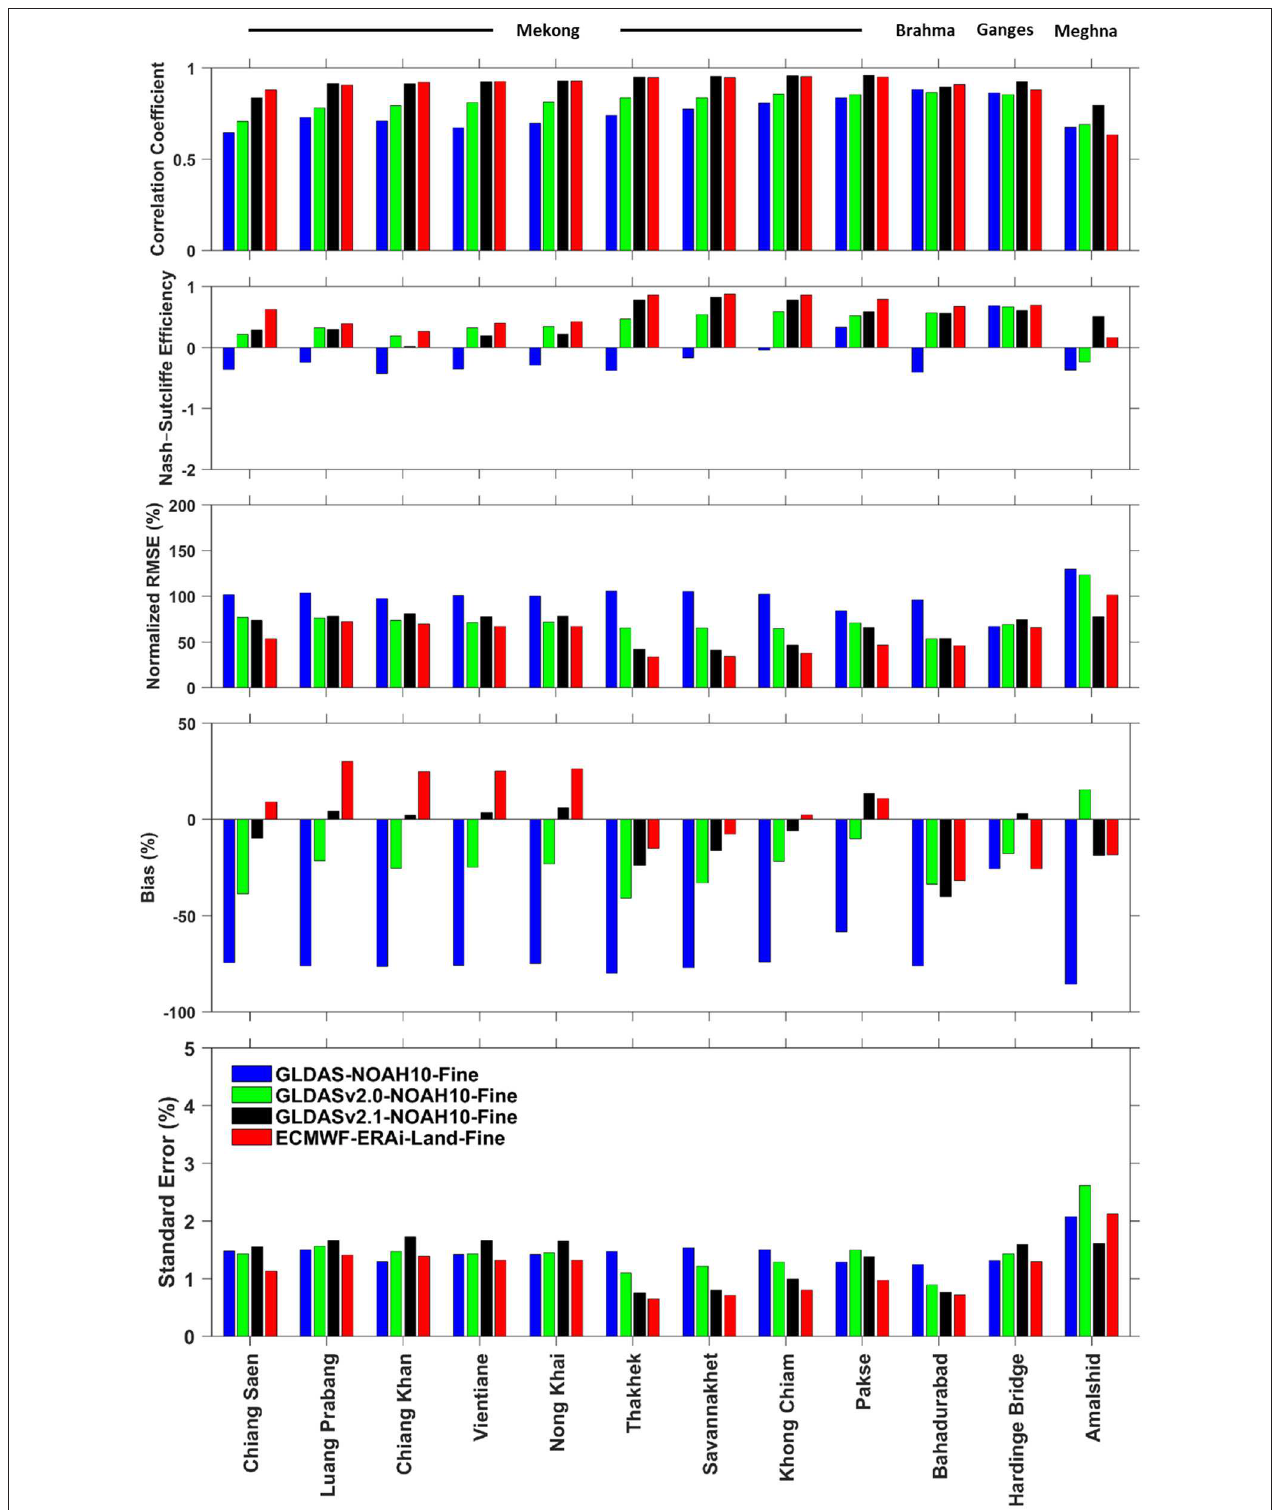
FIGURE 6 | Same as Figure 5 , but as a function of different meteorological forcing in the same LSM (i.e., Noah model).